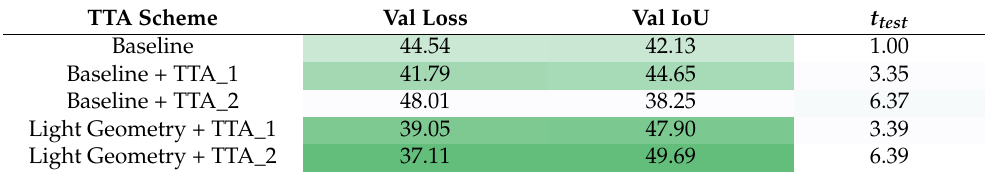
Table 4. Results of applying TTA to the Baseline model and Light Geometry. All loss and IoU scores are in percentage. For loss, lower is better. For IoU, higher is better. Scores are color-coded where a darker green indicates a better